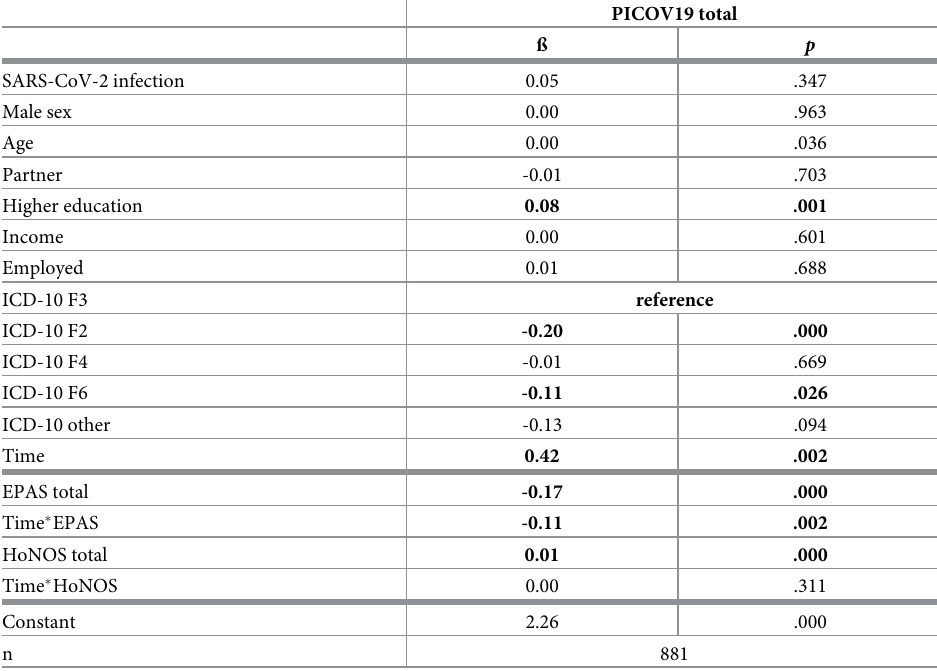
Table 3. Mixed effects regression model for the PICOV19 total score (standardized regression coefficients and p